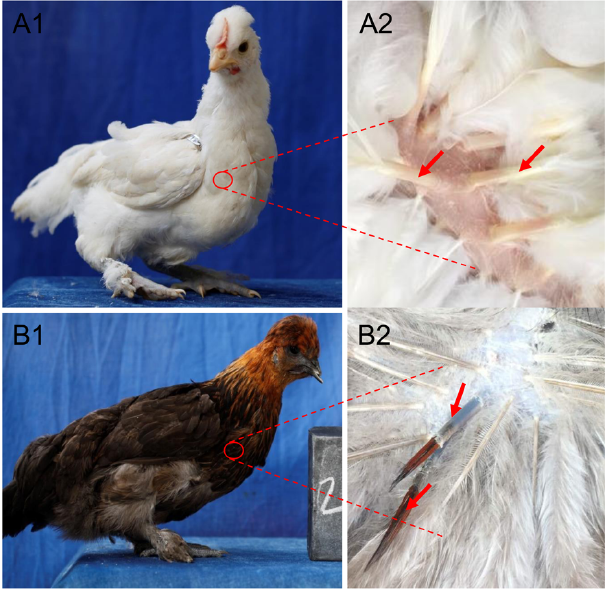
Figure 1. Examples of plumage in chicken: (a1) and (a2) are white; (b1) and (b2) are colored. Red arrows indicate feather bulbs.